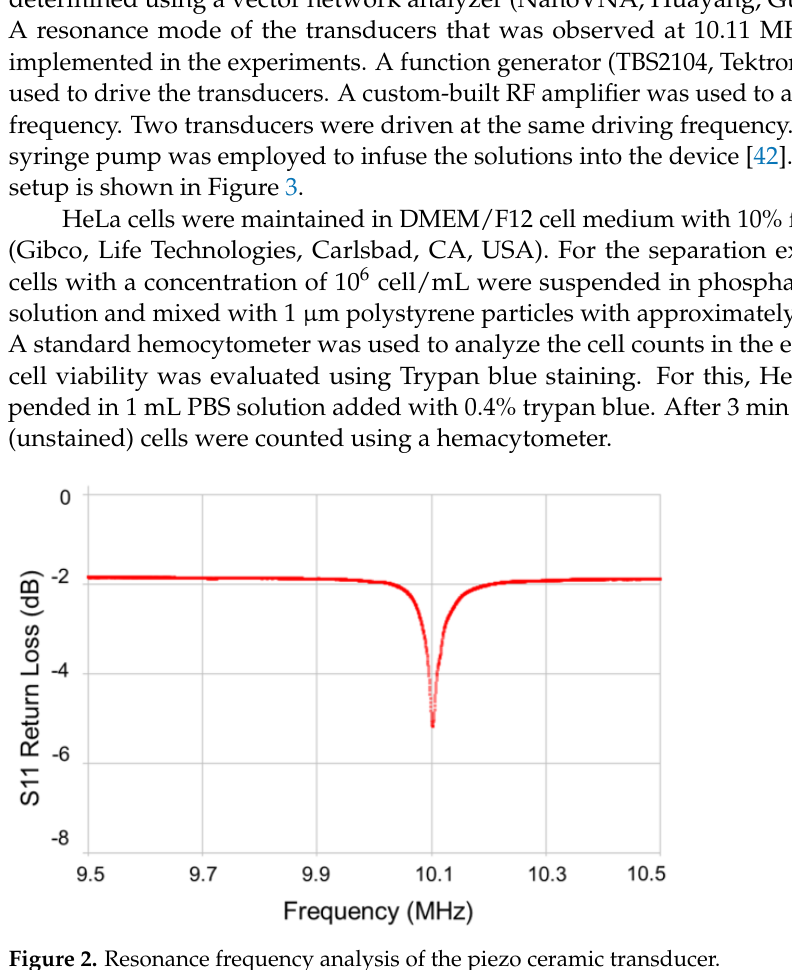
Figure 2. Resonance frequency analysis of the piezo ceramic transducer.